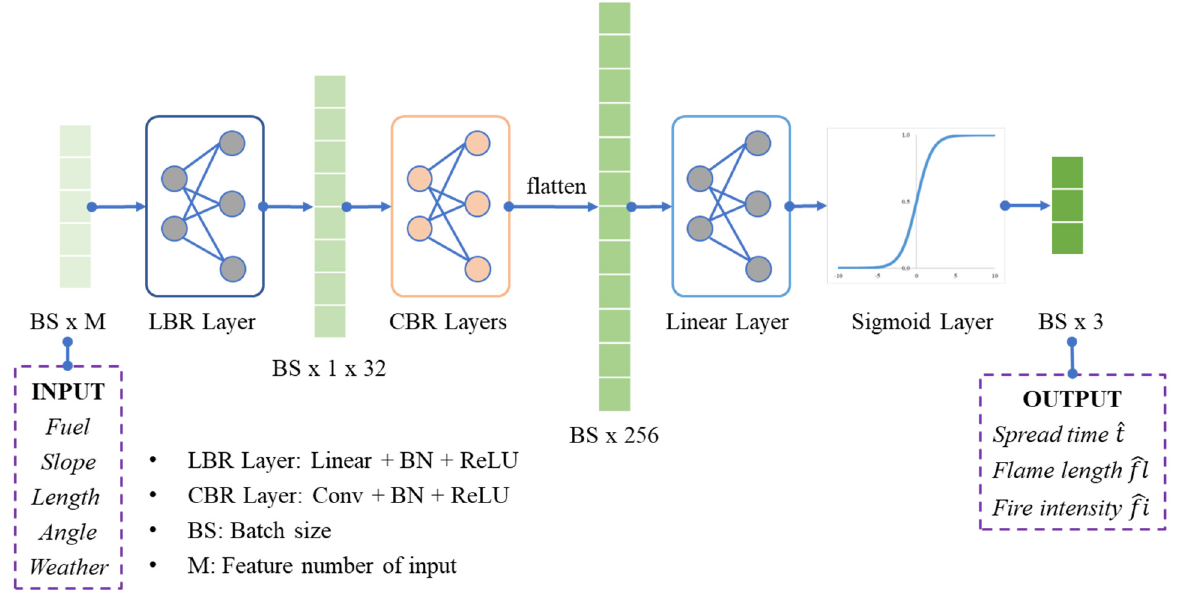
Figure 5. Network architecture of WFDNN